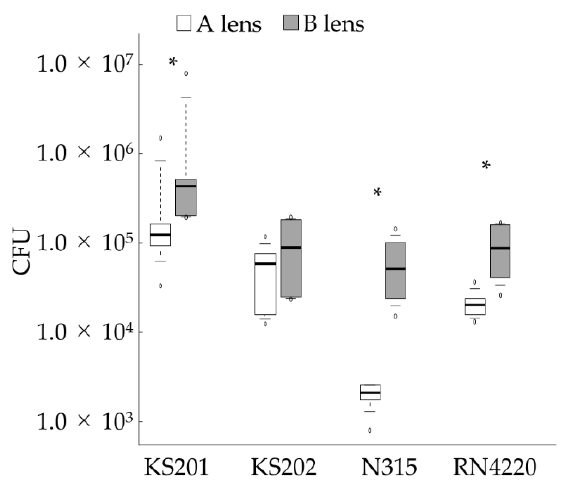
Figure 3. Number of bacteria adhering to the BCLs after 2 h of incubation. Data are presented as median (solid line), interquartile range (box), 10th–90th percentile (whiskers), and minimum and maximum (white circles). * p < 0.05. BCL, Bandage contact lens; CFU, colony forming unit. KS201 and KS202 are two strains of Staphylococcus pseudintermedius ; N315 and RN4220 are two strains of Staphylococcus aureus . The experiment was conducted once using six A and six B lenses per bacterial